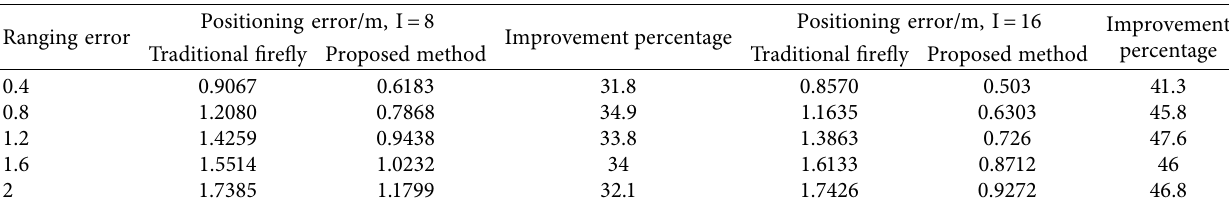
Table 2: Improvement percentage of the positioning performance.